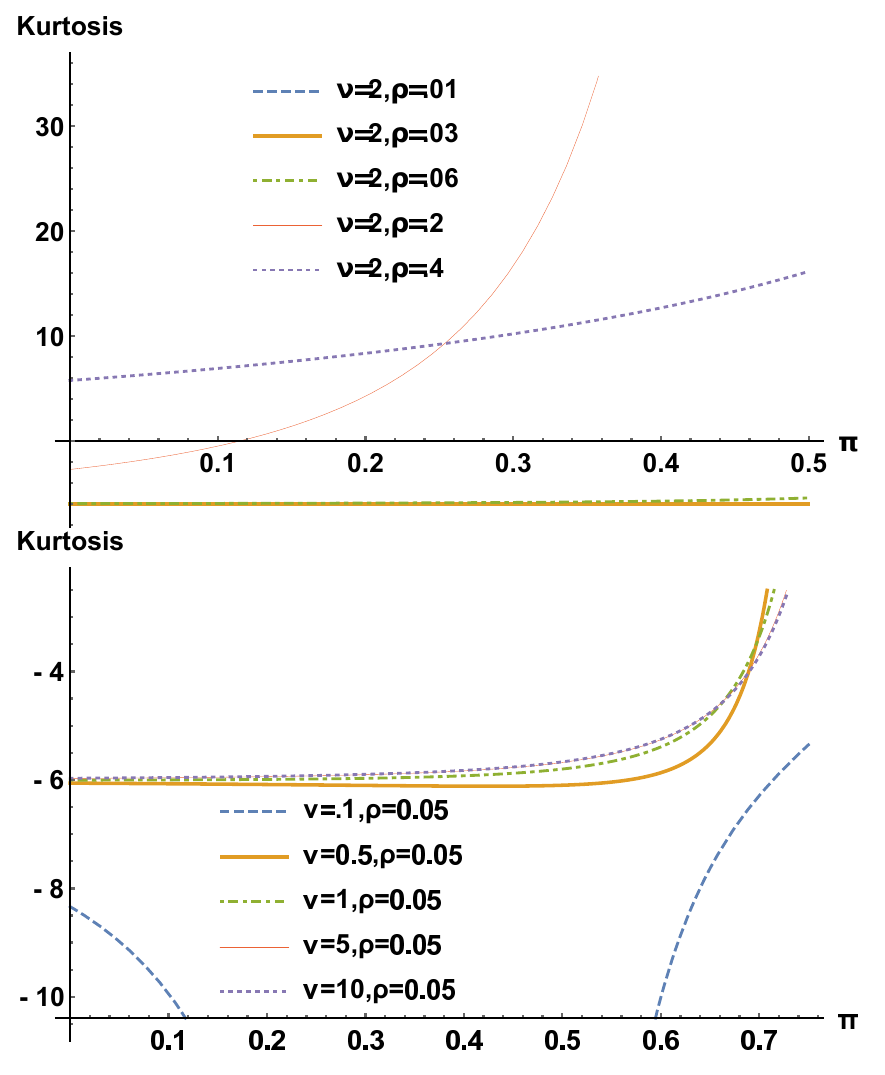
Figure 8 – Plots of kurtosis of ZIAHPD for particular values of its parameters.